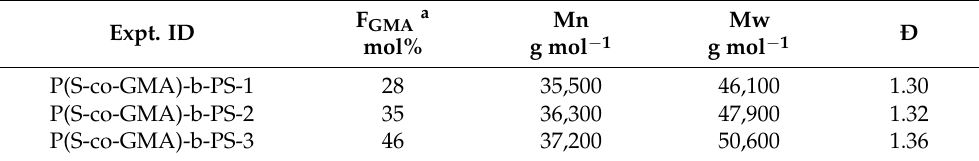
Table 2. Molecular properties of synthesized P(S-co-GMA)-b-PS copolymers used as polymeric chain extenders of